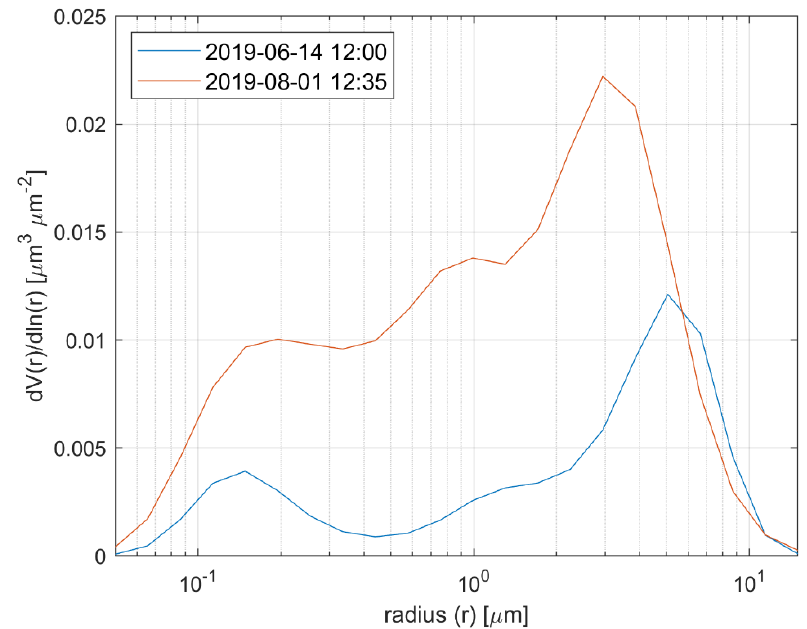
Figure 16. Particle volume size distribution for 14 June 12:00 UTC ( blue ) and 1 August, 12:35 UTC ( red ), measured by the sun-photometer. The observation is retrieved from AERONET level 1.5 production, with Almucantar (June, blue) and Hybrid (red, July) sky scenario accordingly, which is available online (see in Section 7 of Supplementary Materials).